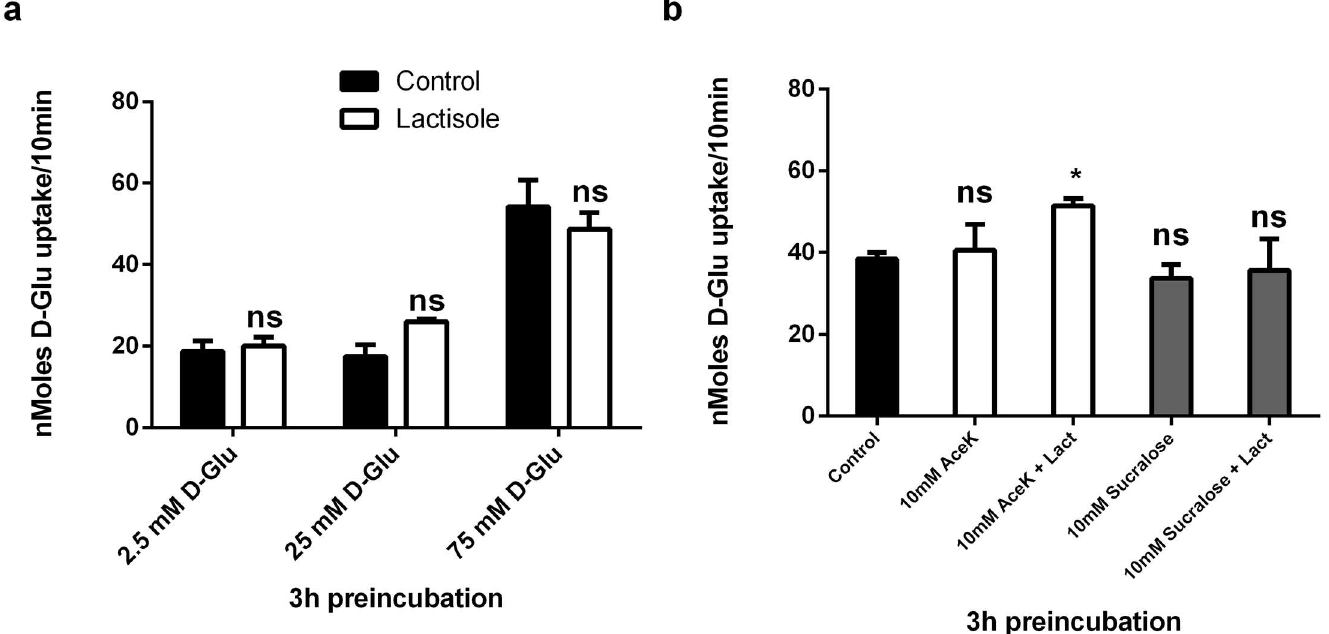
Fig 4. Acute effectsof the sweet taste inhibitor, lactisole and artificial sweeteners on carriermediated glucose transport in Caco-2/TC7 cells. (a) Caco-2/TC7 cells grown for 21 days were incubatedwith 2.5, 25 and 75 mM D-Glucosefor 3hrs in the presenceor absenceof 0.5 mM lactisole, washedthree times with glucosefree KBS, followedby 10 min exposureto [ 14 C] 10 mM D-Glucose. Osmolarity was adjusted by addingMannitol.(b) Cells were incubatedwith 75 mM D-Glucosein the presenceof 10 mM AcesulfameK (AceK) or Sucralose with the additionof lactisoleat 0.5mM. Osmolarity was adjustedfor by addingMannitol.Cellularuptake of D-Glucosewas measuredby radioactivescintillation spectrometry. Uptake is corrected for simple diffusionof 10 mM [ 14 C] L-Glucose. Data are expressedas nMoles D-Glucoseuptake/well/10min ± SD of n = 4 per condition.ns = not